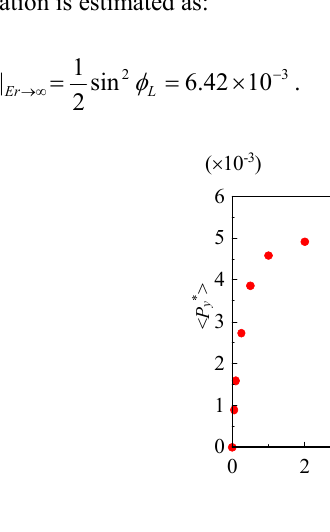
Fig.8 Effect of Er on flexoelectric polarization for Ae=100